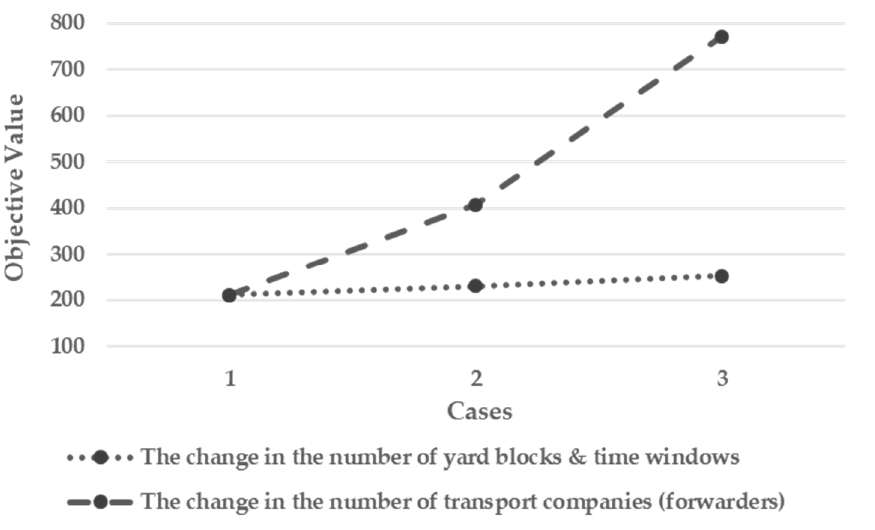
Figure 7. The relationship between the transport company (forwarder) and the change in the number of yard blocks, time windows, and transport companies (forwarders).